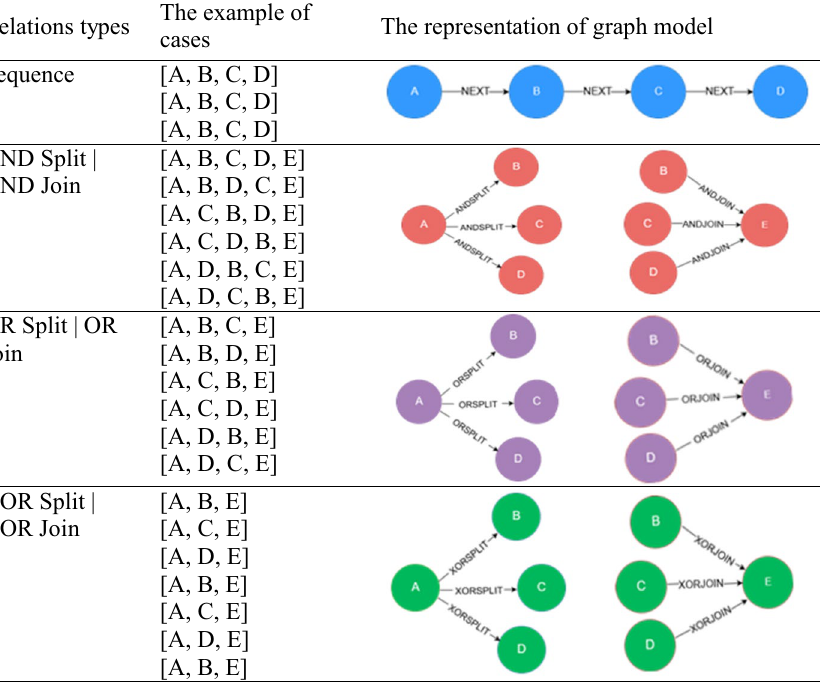
Table 2 Control-flow patterns in process model Relations